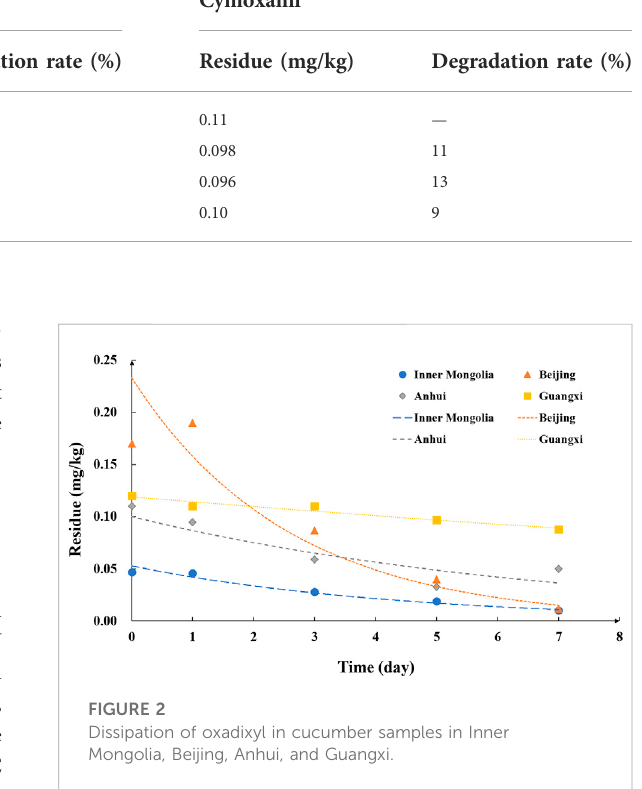
TABLE 5 Storage stability results of oxadixyl and cymoxanil in cucumber under frozen conditions. Storage interval (d)